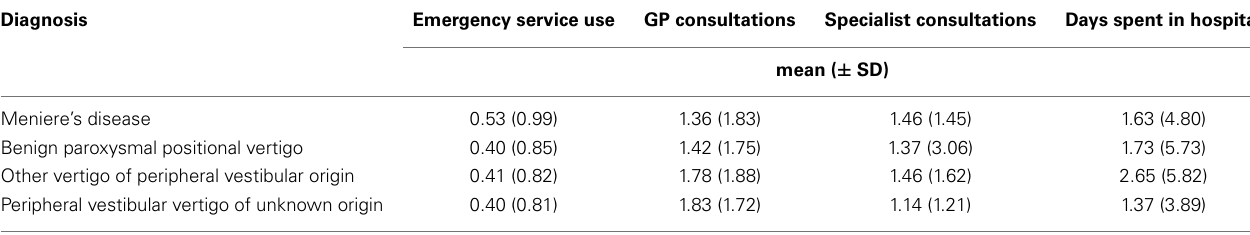
Table 2 | Healthcare utilization during the 3months beforeVisit 1 by diagnosis.